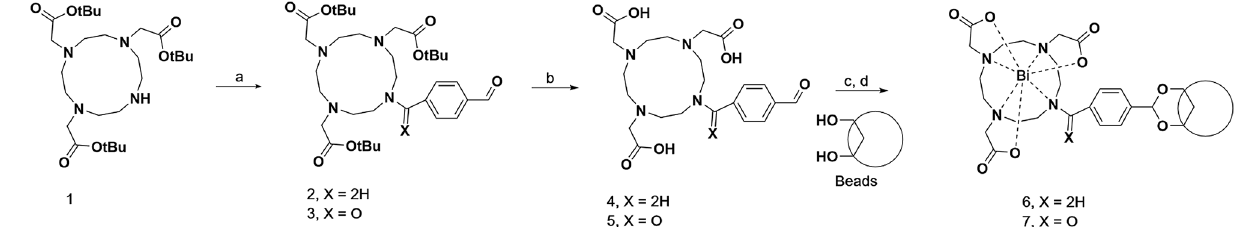
Figure 1. Synthesis of bismuth beads with an aromatic linker between the bead and the macrocycle. Reagent and condition: ( a ) 4-(bromomethyl)benzaldehyde, K 2 CO 3 /DMF or 4-formyl benzoyl chloride, DCM/Et 3 N, ( b ) HCl/dioxane, ( c ) MeSO 3 in DMF or DMSO, 50 °C, ( d ) Bi(CF 3 SO 3 ) 3 , pH 8–9 using NaHCO 3 , 80 °C or NMP/ pyridine, 55